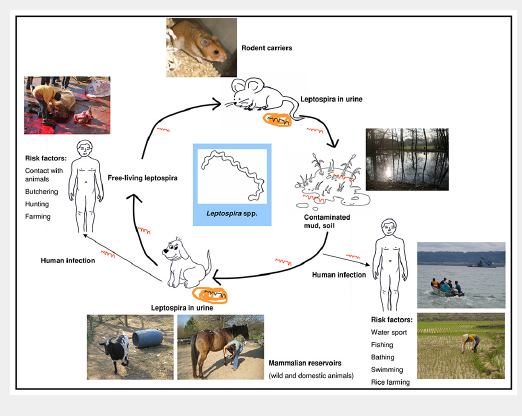
Life cycle of pathogenic Leptospira spp., the infectious agents of